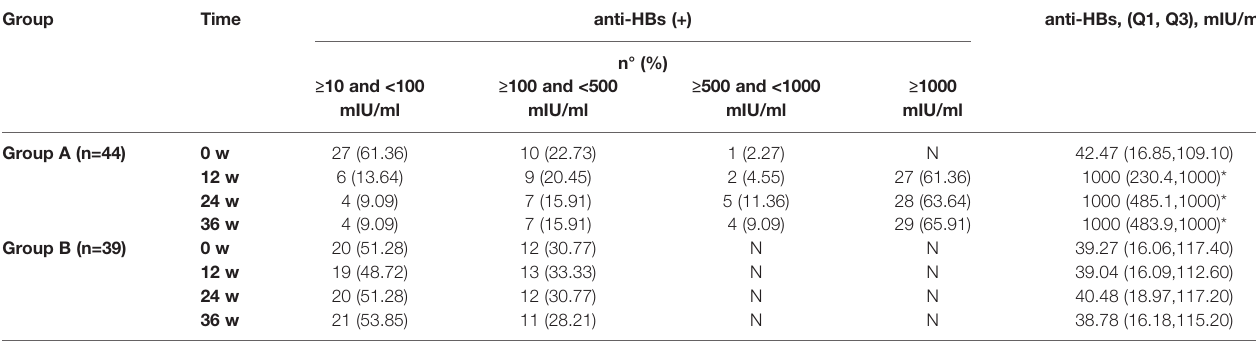
TABLE 4 | Results of serum hepatitis B virus surface antibody test in OBI patients.